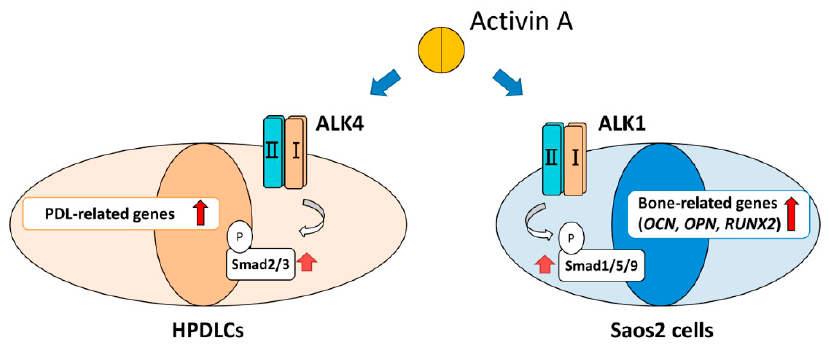
Figure 7. Schema of activin A-induced bifunctional effects on differentiation of HPDLCs and Saos2 cells.